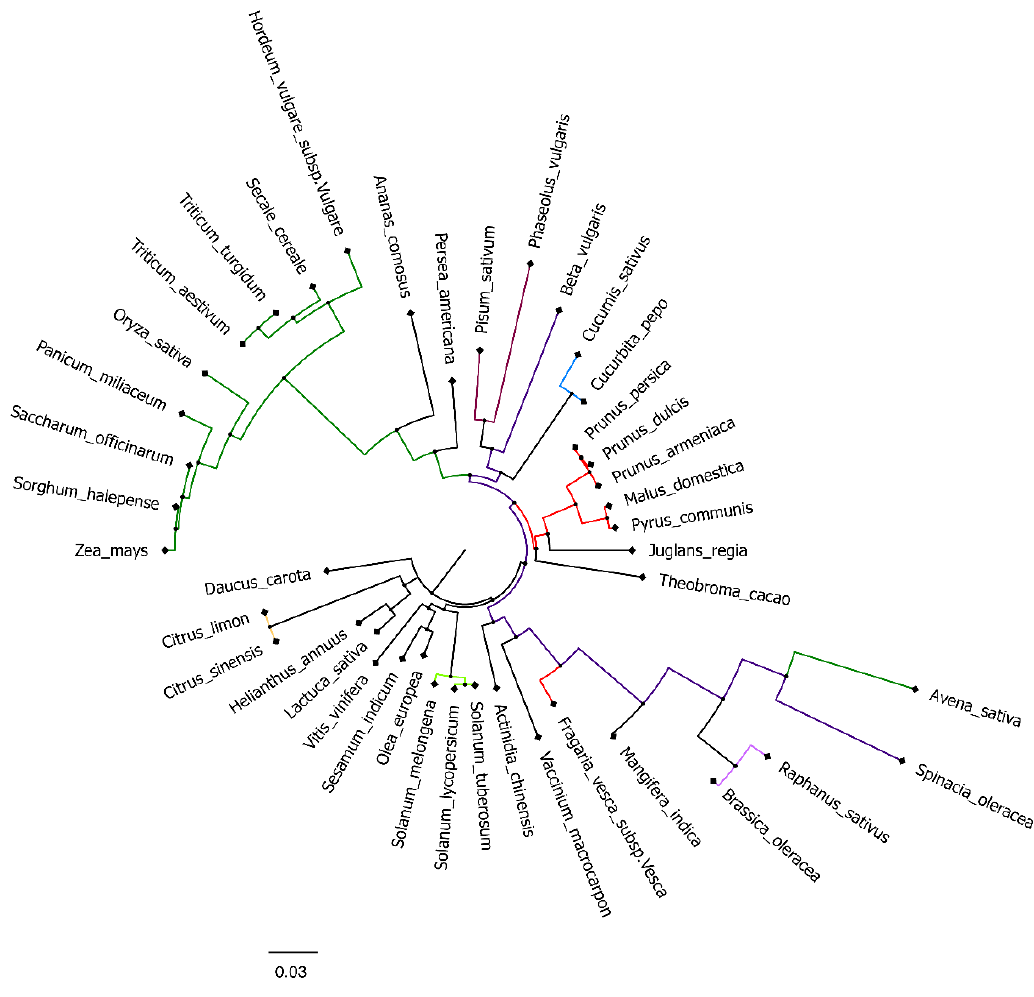
Figure 1. Phylogenetic tree of trnL (UAA) intron sequence of 42 horticultural crops including apple ( Malus domestica ), pear ( Pyrus communis ), peach ( Prunus persica ), and kiwi ( Actinidia chinensis ). Branches having the same color correspond to the same family. Green: Poaceae ; red: Rosaceae ; dark violet: Chenopodiaceae ; light blue: Cucurbitaceae ; light green: Solanaceae ; yellow: Rutaceae and violet: Fabaceae . Bootstrap values from 1000 replicates were used to estimate the confidence limit of the nodes. The scale bar represents a 0.03 estimated base substitution.